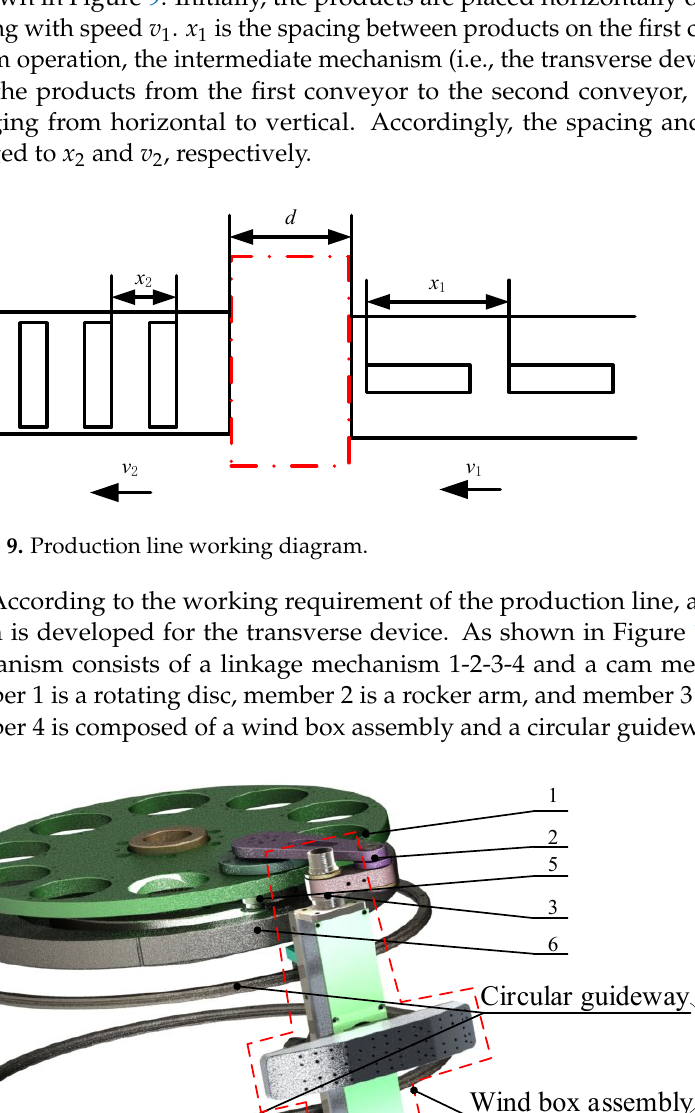
Figure 8 . Physical diagram of the transverse device.